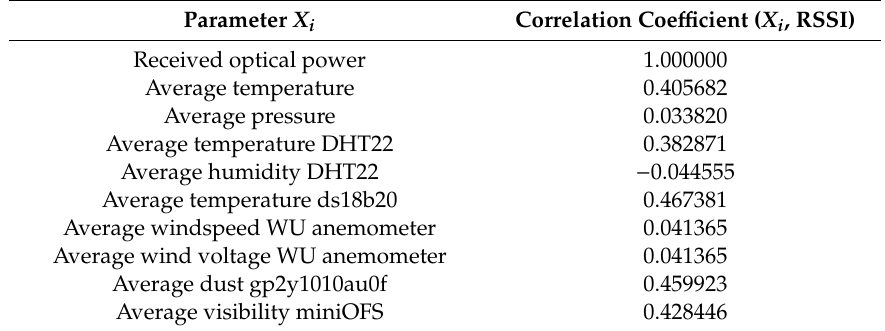
Table 2. Correlation of input parameter with output parameter received signal strength identifier